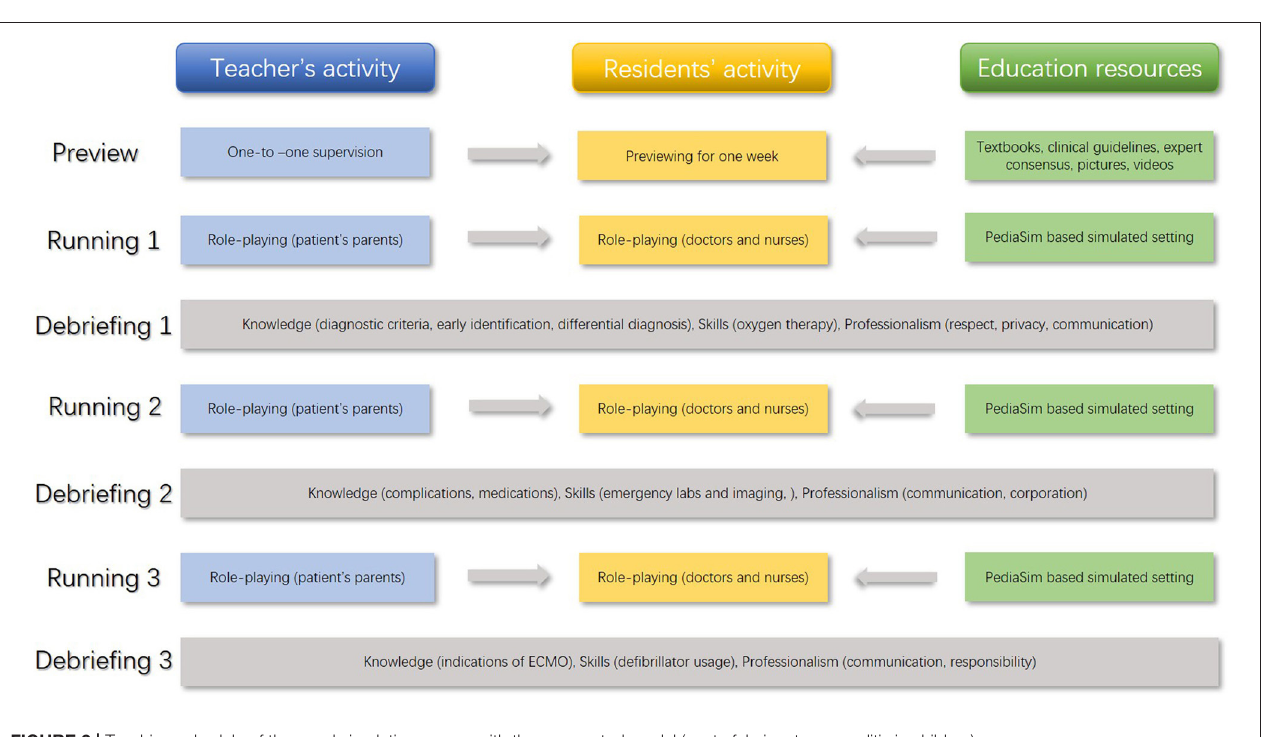
schedule of the novel simulation course with the segmented model are shown in Figure 2 . Figure 1 shows the residents’ demands for each specific type of course content. The horizontal arrow